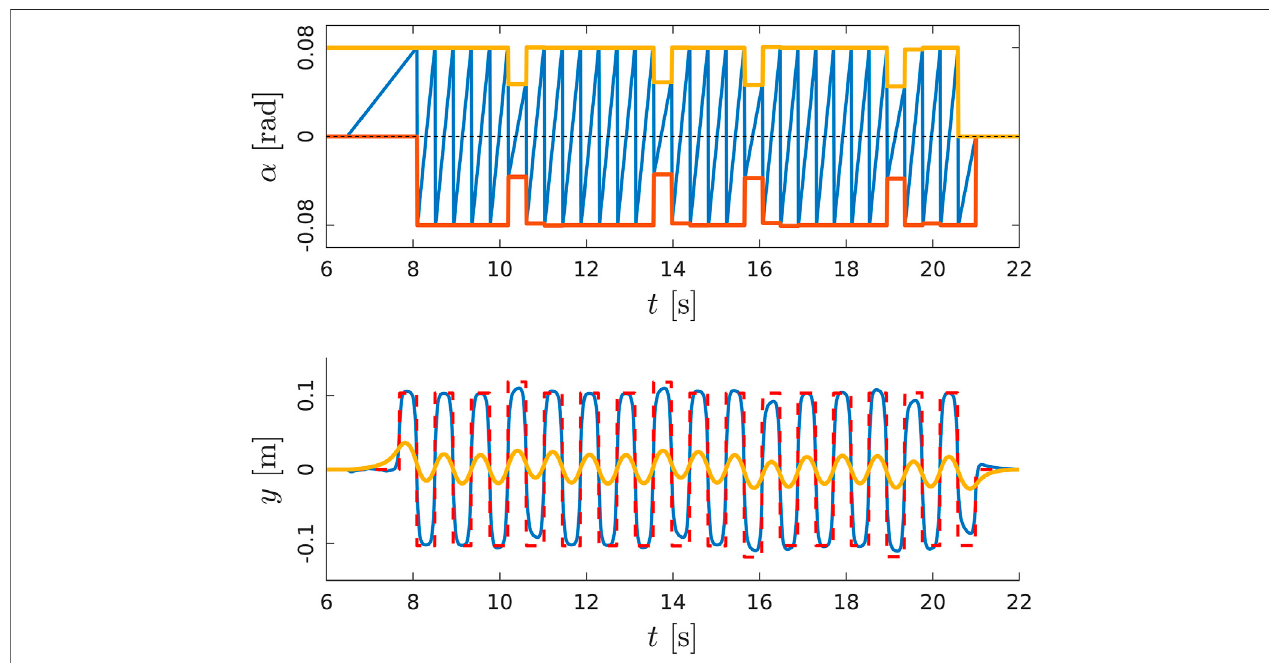
FIGURE 12 | Top: evolution of the phase variable α sag (in blue) in the sagittal plane during a walk in simulation, increasing at each cycle from α min sag (in red) to α max sag (in yellow). Bottom: the ZMP input reference of the PC (in red) and the tracked ZMP (in blue). The output of the PC is the CoM trajectory (in yellow) commanded to the robot.Sequence of frames of COMAN + walking 32 steps in simulation while changing the heading direction.